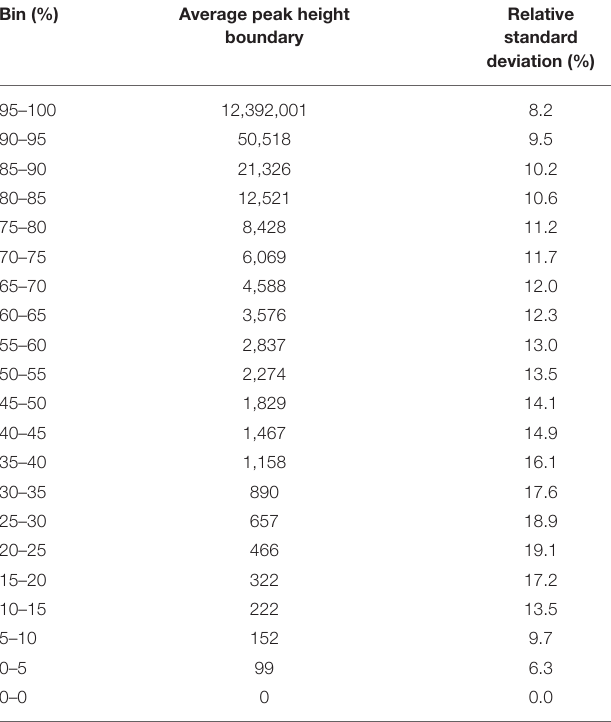
TABLE 1 | Distribution of peak height values across 499 files. TABLE 3 | Peak rejections by different peak height thresholds on the individual file